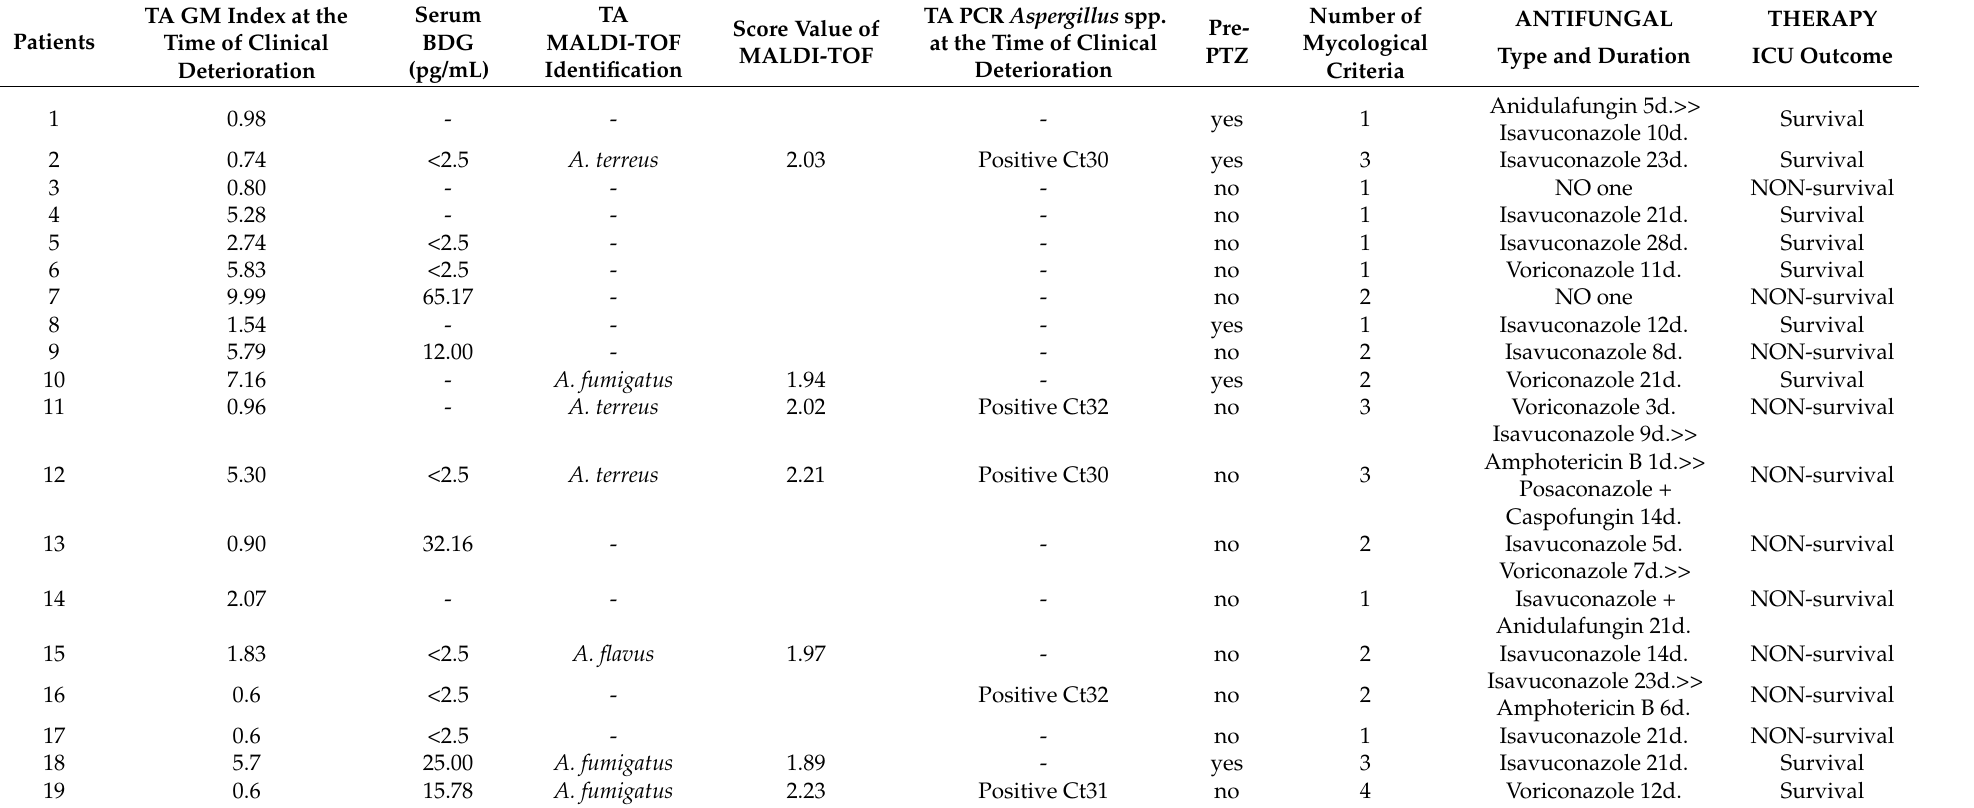
Table 1. Microbiological data and systemic antifungal therapy from patients fulfilling the CAPA-IP criteria.